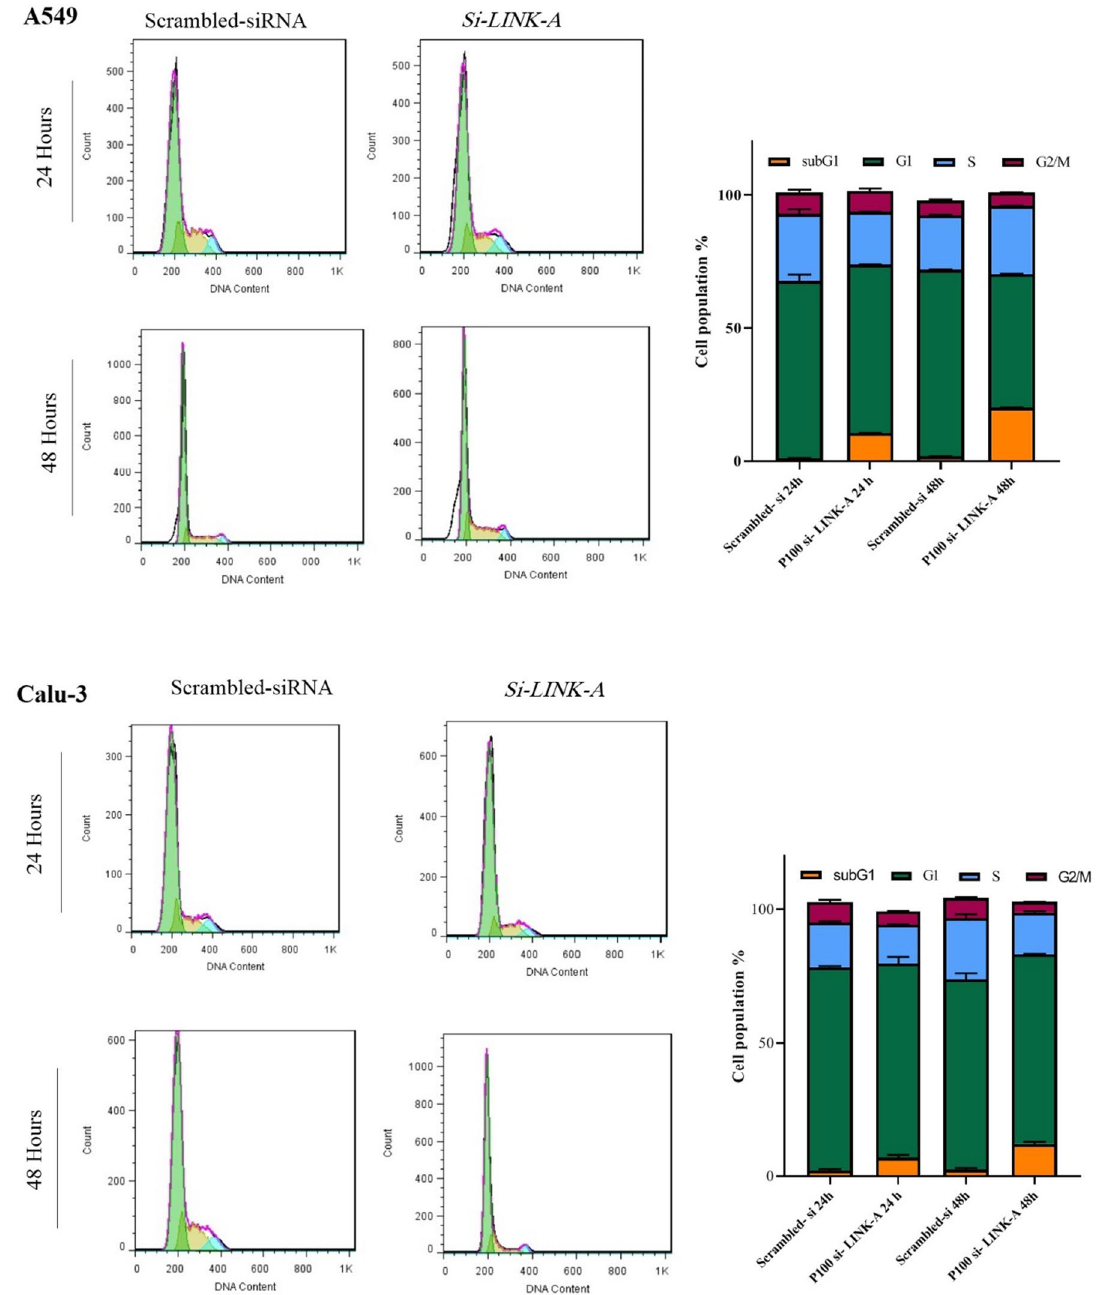
Figure 5. Flow cytometric analysis of cell cycle by PI staining in LINK-A silenced cells. Note. Cell cycle analysis after 24 and 48 hours from transfection with scrambled siRNA (as control groups) and LINK-A siRNAs in A549 and Calu-3 cell lines. The graphs are presented for each cell line separately, which show the distribution of the cell population in various phases of the cell cycle. Data are presented as the mean ±